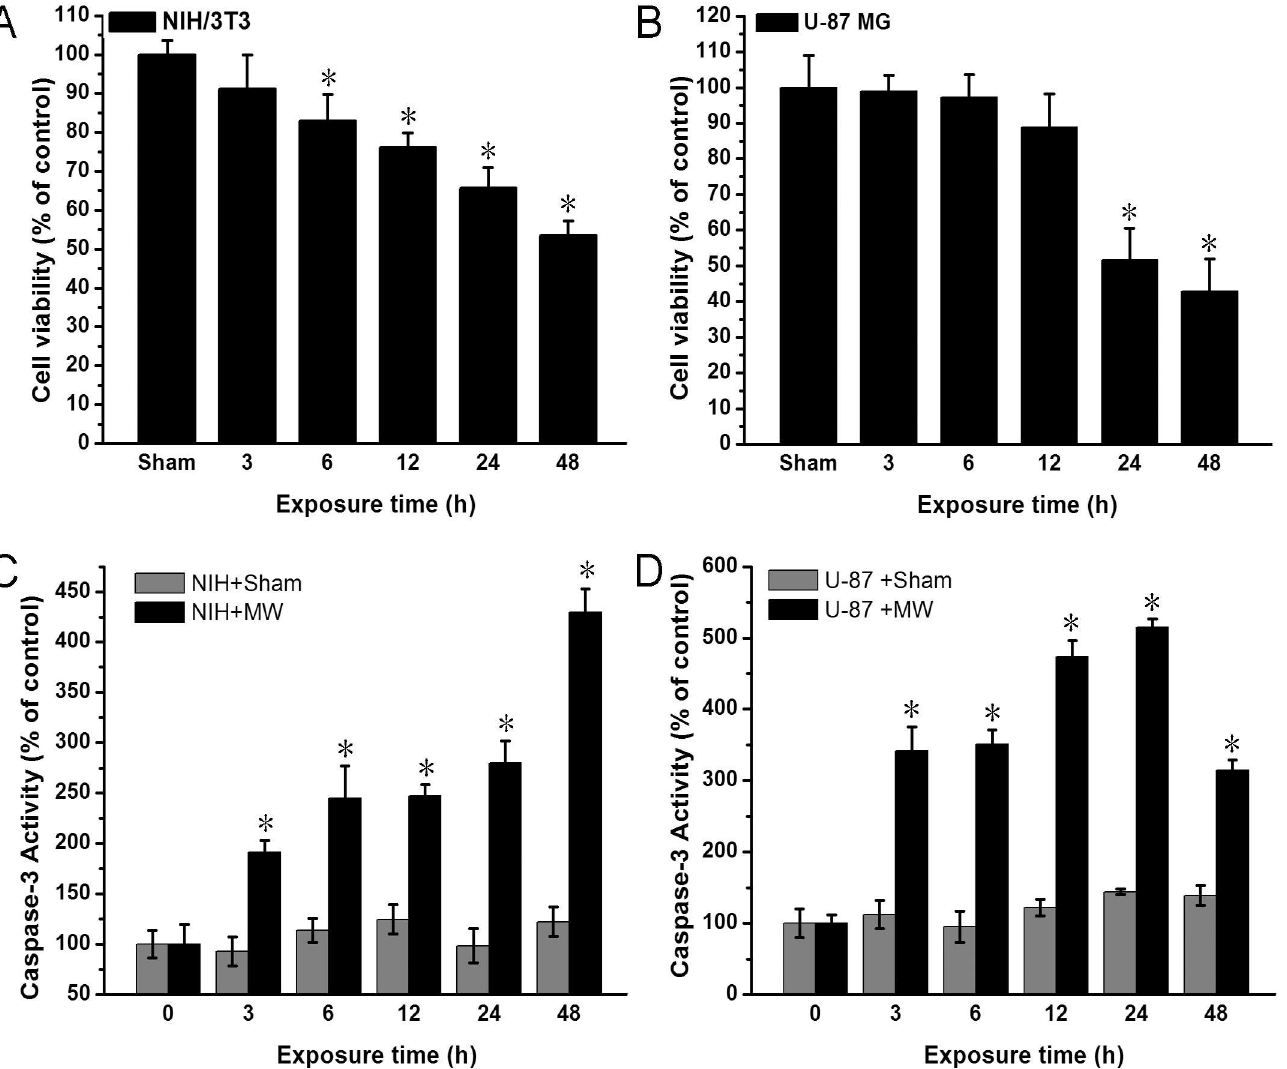
Fig 2. 1800 MHz microwave induces caspase-3activation and decreasein cell viability. (A, B) Levels of cell viability after 1800MHzmicrowave radiationfor the indicatedtime in NIH/3T3 and U-87 MG cells. Cell CountingKit-8 (CCK-8, DojindoLaboratories, Kumamoto, Japan) was used to evaluate cell viabilityafter various treatments. (C, D) Levels of caspase-3 activity after 1800MHz microwave radiation for the indicatedtime in NIH/ 3T3and U-87 MG cells. After microwave radiation, cells were harvested, and caspase-3activity was measured by the caspase-3 activity kit. MW, microwave. Data are the mean ± S.D. (n = 3; * P < 0.05 vs. sham